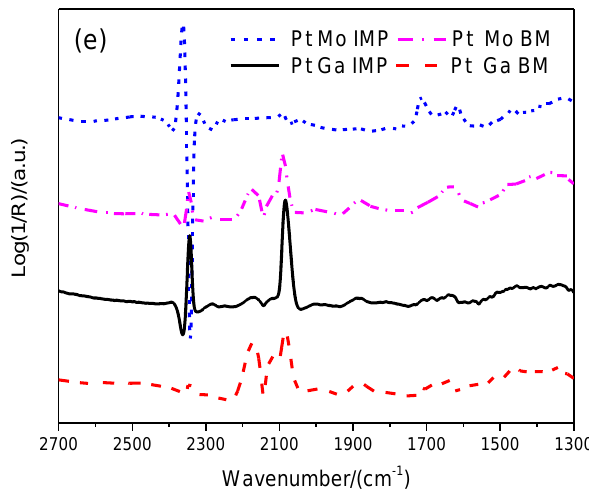
Figure 5. Evolution of the in situ CO-FTIR spectra of the Pt Mo IMP ( a ), Pt Mo BM ( b ), Pt Ga IMP ( c ), and Pt Ga BM ( d ) under N 2 during 40 min, and the stable spectra of these samples ( e ). All of the samples are in situ reduced at 500 °C.